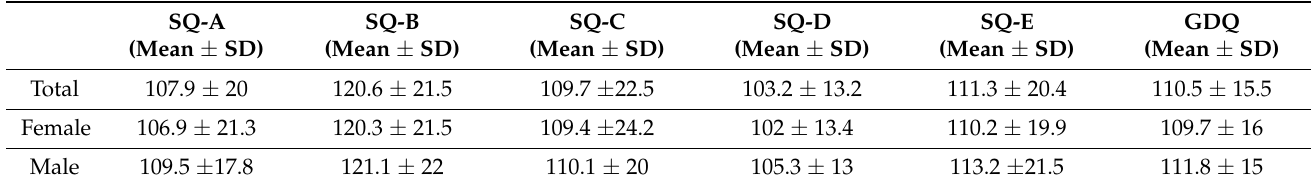
Table 2. Griffiths scales scores at 24